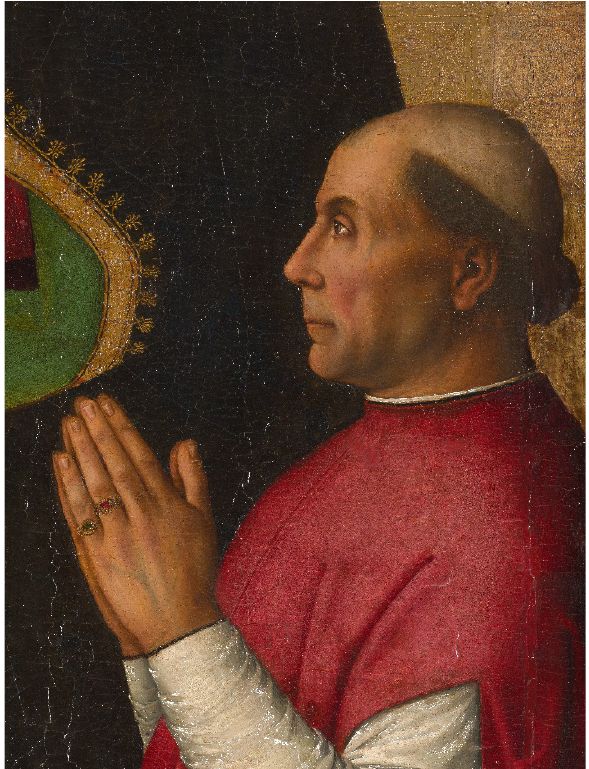
Figure 12 . The Virgin represented as Mater Sapientae .